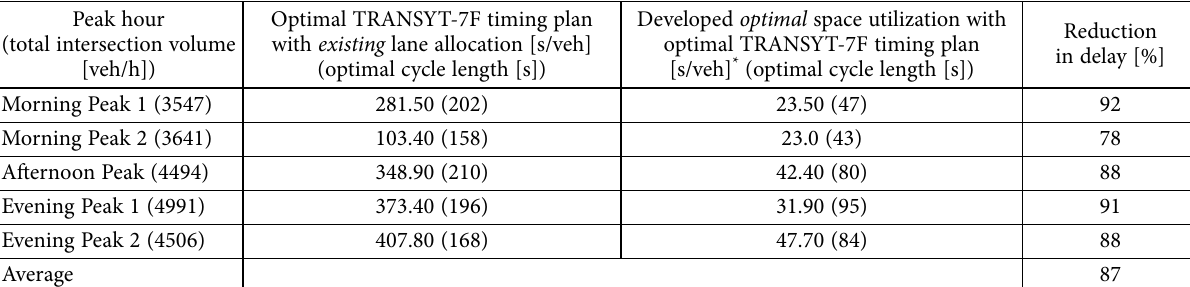
Table 1. TRANSYT-7F average intersection delay with the optimal TRANSYT-7F timing plan and the effect of the space optimization